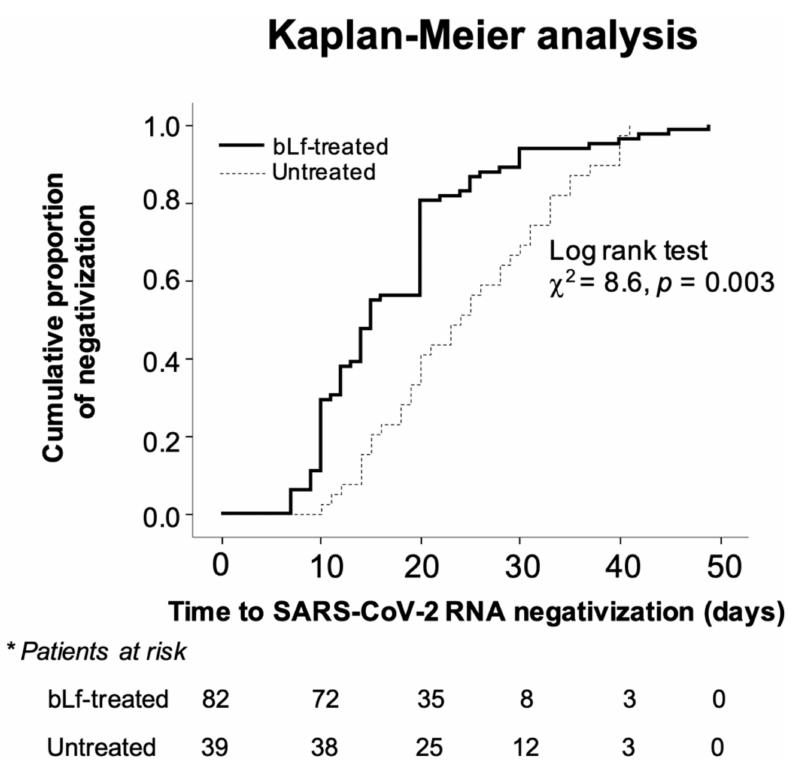
Figure 4. Cumulative proportion of SARS-CoV-2 RNA negativization as a function of time in patients treated and untreated with bovine lactoferrin (bLf). * Number of patients of both groups SARS-CoV-2 RNA-positive at different time points.